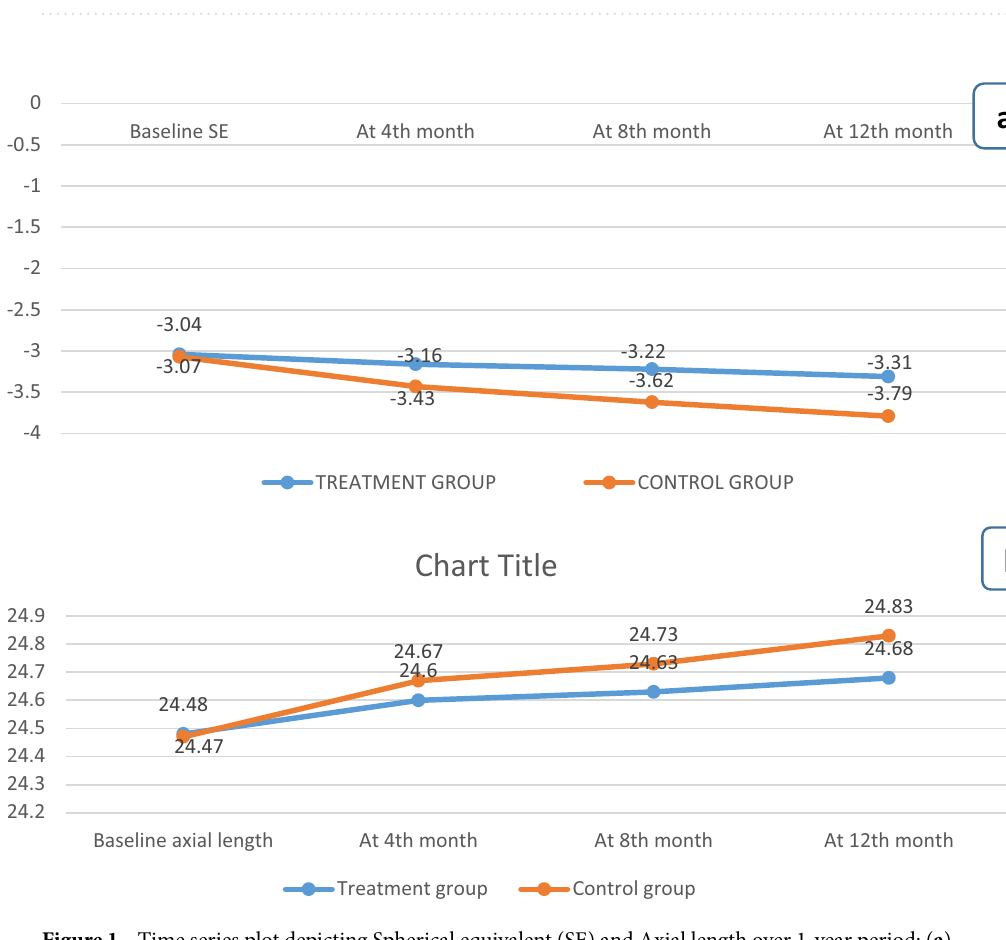
Table 2. Average of studied parameters (after the completion of 1-year) in treatment and control eyes. D Diopter, mm millimeters, MP Myopia progression, ALE axial length elongation, TRMP True reduction in Myopia progression in treatment eyes compared to control, TRALE True reduction in ALE in treatment eyes compared to control, %TRMP percentage TRMP, %TRALE percentage TRALE.